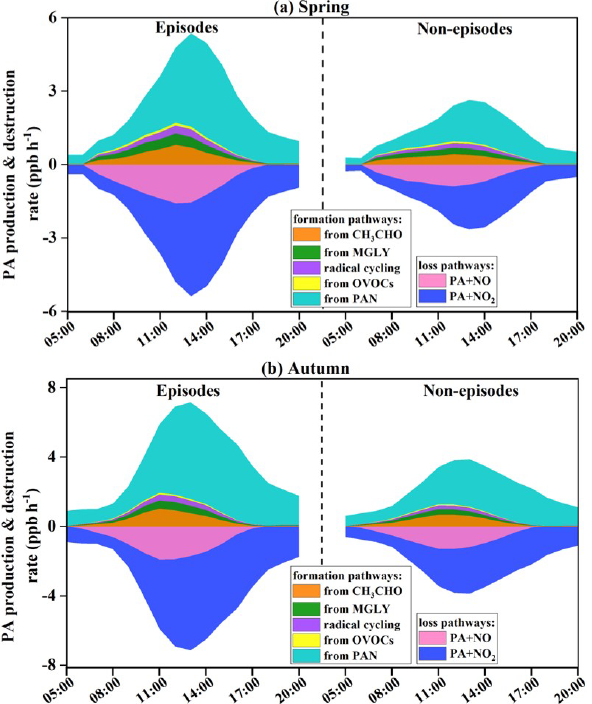
Figure 5. Formation and destruction rates of PA radical (hence PAN) during episodes and non-episodes in (a) spring and (b) au- tumn, respectively.